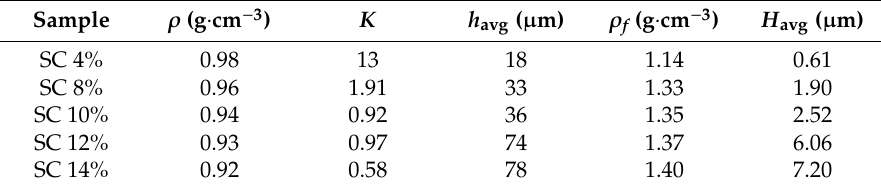
Table 3. Density of SC solutions ( ρ ), dimensionless K factor, average liquid film thickness on fennel ( h avg ), density of SC film ( ρ f ), and average dry coating thickness on fennel ( H avg ) as function of SC